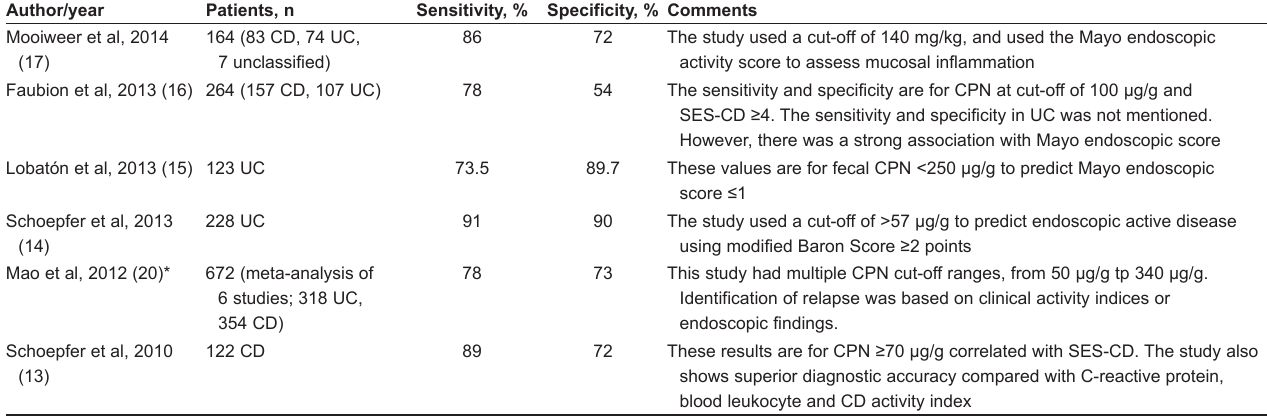
TABLE 3 Summary of the major studies correlating fecal calprotectin (CPN) with inflammatory bowel disease activity/relapse